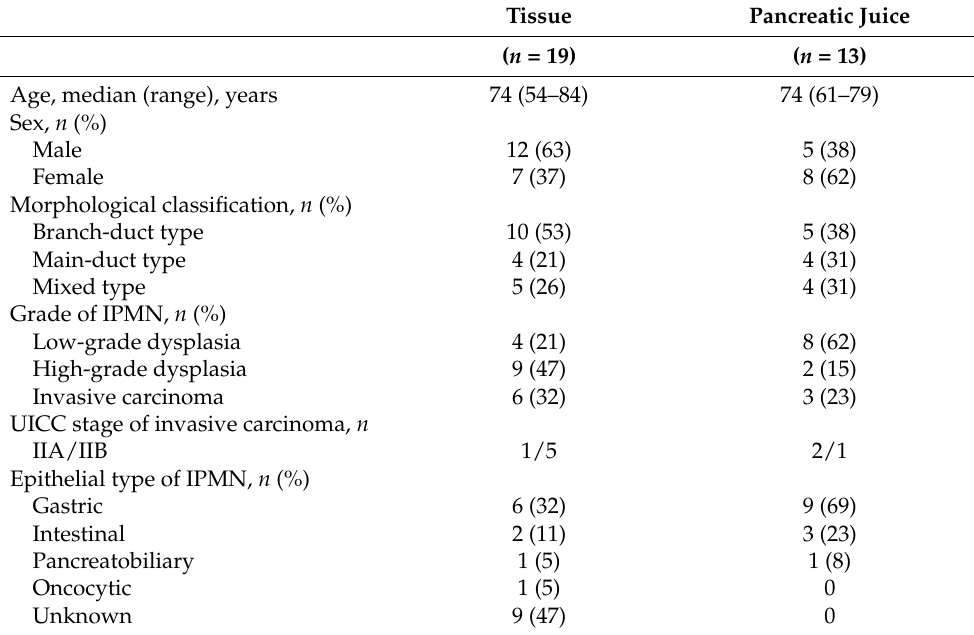
Table 2. Summary of clinicopathological